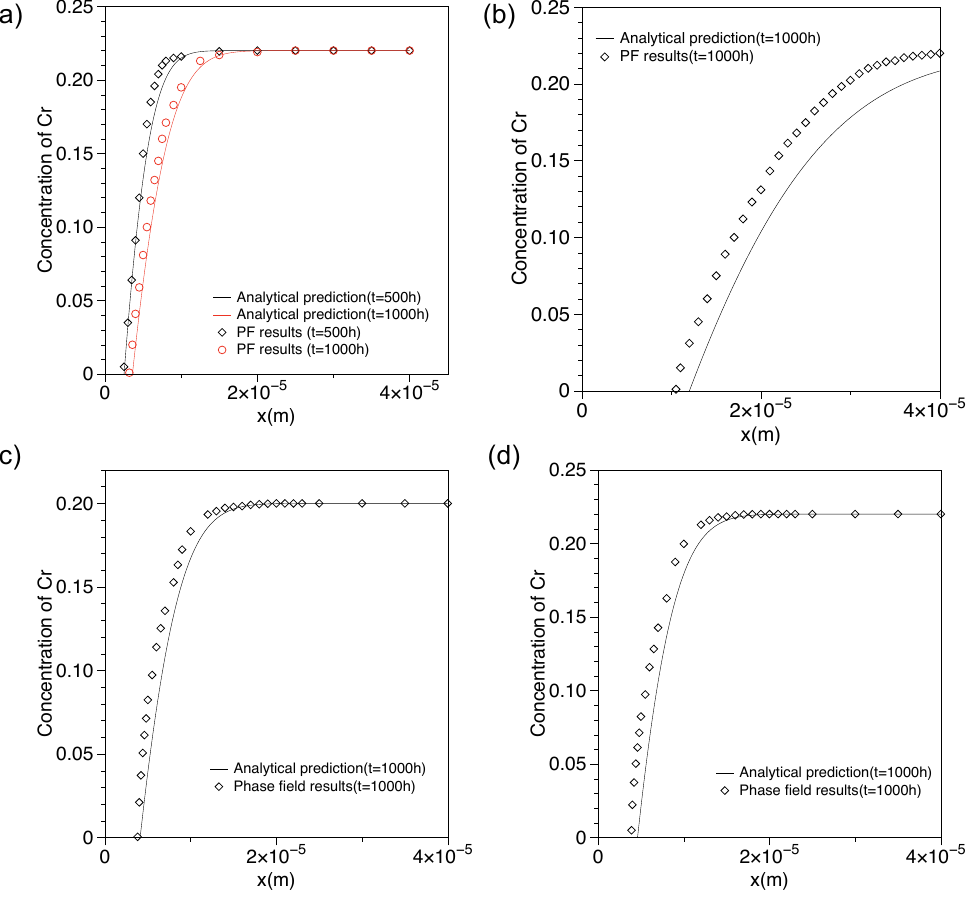
Figure 5. Comparison of the PF results and the predictions of Wagner’s theory for the Cr concentration ahead of the interface of the Cr 2 O 3 /matrix phase when ( a ) T = 1073 K, N 0 = 0.05, N 0 = 0.22, ( c ) T = 1073 K, N 0 ( b ) T = 1173 K, N 0 O Cr = 0.07, N 0 = N 0 O Cr